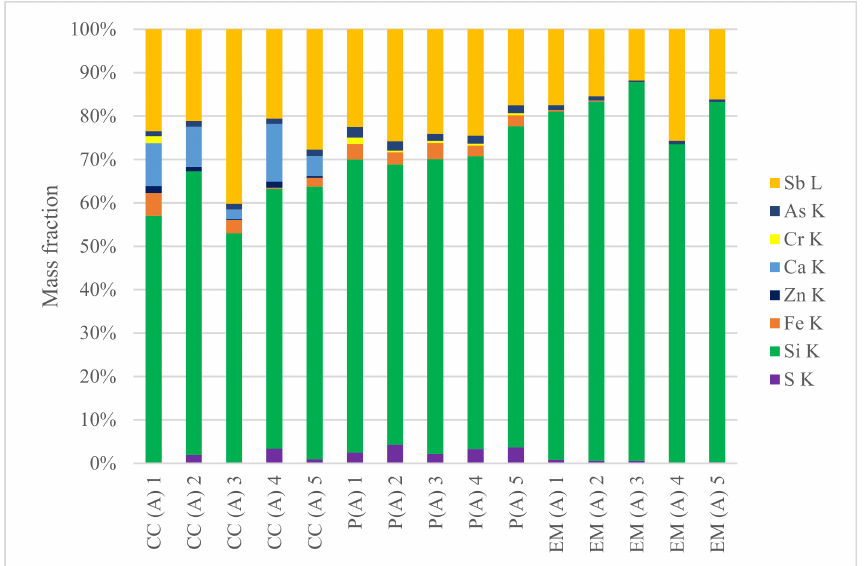
Figure 5. SEM-EDS quantitative microanalysis of deposits from extreme layers (CC—combustion chamber, P—piston, EM—exhaust manifold of engine from landfill A; numbers 1–5—different points of sampling; K and L—the atomic excited energy levels).